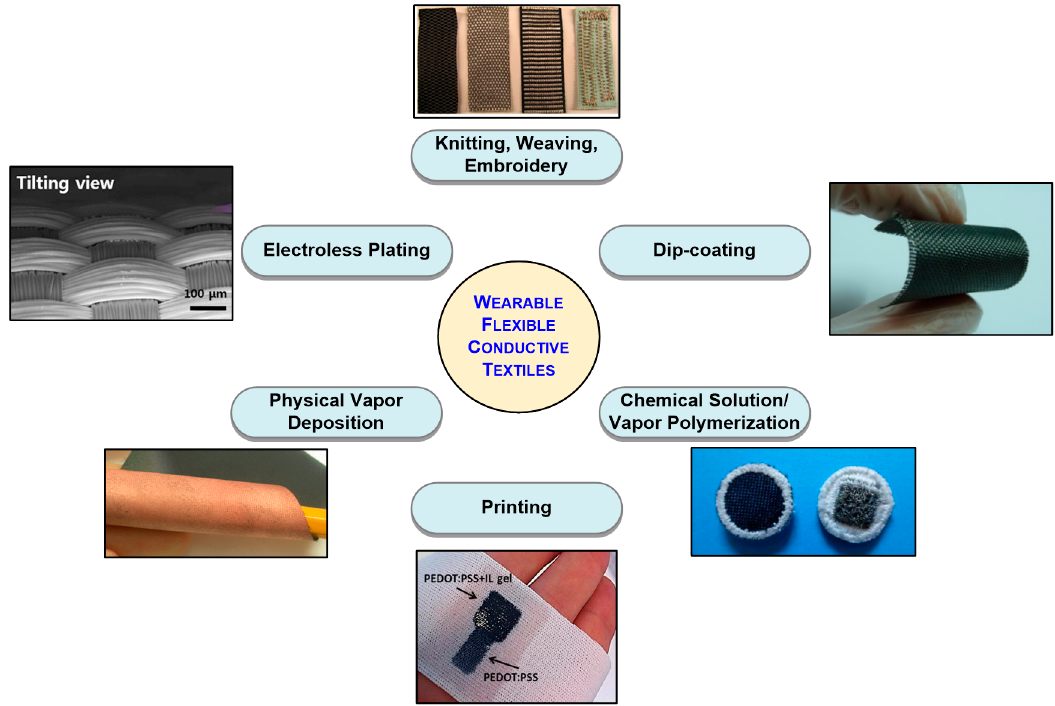
Figure 1. Primary methods of realizing conductive textiles [3,26,27–30].